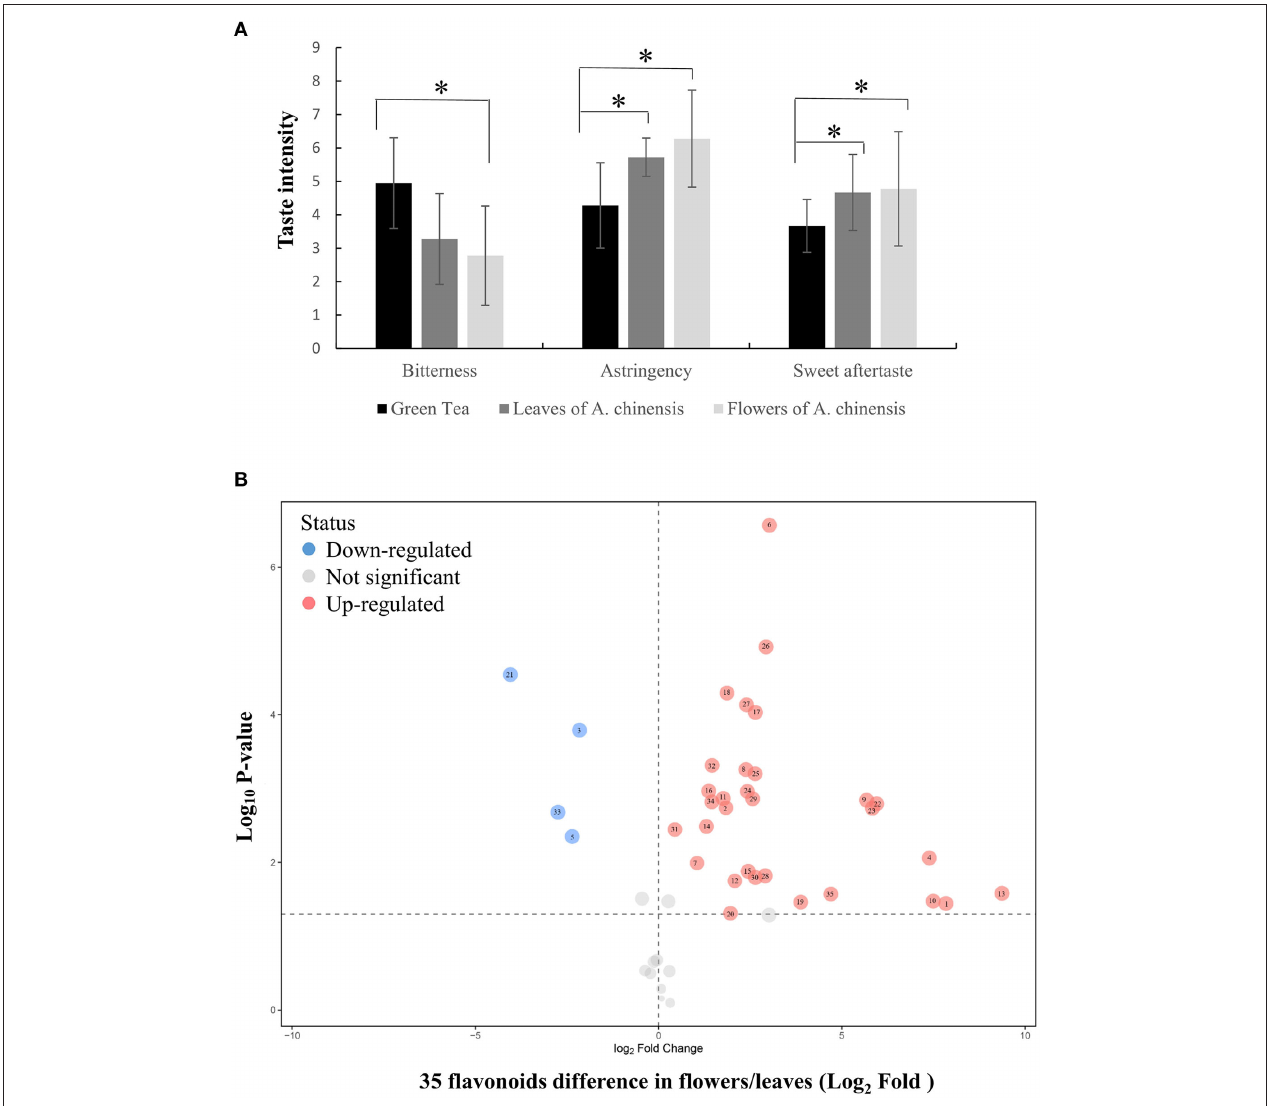
FIGURE 1 | Sensory evaluation and flavonoid profile of A. chinensis herbal tea. (A) The taste intensity of green tea, herbal tea madding from flowers and leaves of A. chinensis . (B) The flavonoid differential analysis between flowers and leaves. 1, (-)-Epigallocatechin; 2, Apigenin; 3, Astilbin; 4, Astragalin; 5, Avicularin; 6, Chalconaringenin; 7, Chrysin; 8, Cianidanol; 9, Cynaroside; 10, Dihydromyricetin; 11, Engeletin; 12, Galangin; 13, Gallocatechin; 14, Genkwanin; 15, Hyperoside; 16, isoliquiritigenin; 17, Isoquercitrin; 18, Isorhamnetin; 19, Isorhamnetin-3-O-nehesperidine; 20, Isosakuranetin; 21, Kaempferitrin; 22, Kaempferol; 23, Kaempferol-3-O-rutinoside; 24, Myricitrin; 25, Narcissoside; 26, Naringenin; 27, Narirutin; 28, Phloretin; 29, Pinocembrin; 30, Procyanidin B1; 31, Procyanidin B2; 32, Quercetin; 33, Quercitrin; 34, Rutin; 35, Tiliroside. Data were statistically evaluated using Student’s t test (* P < 0.05).